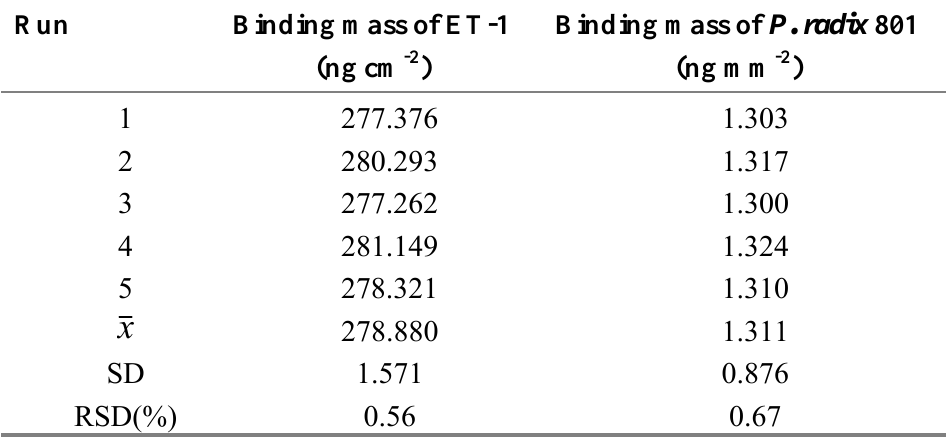
Table 2. Reproducibility and reliability of